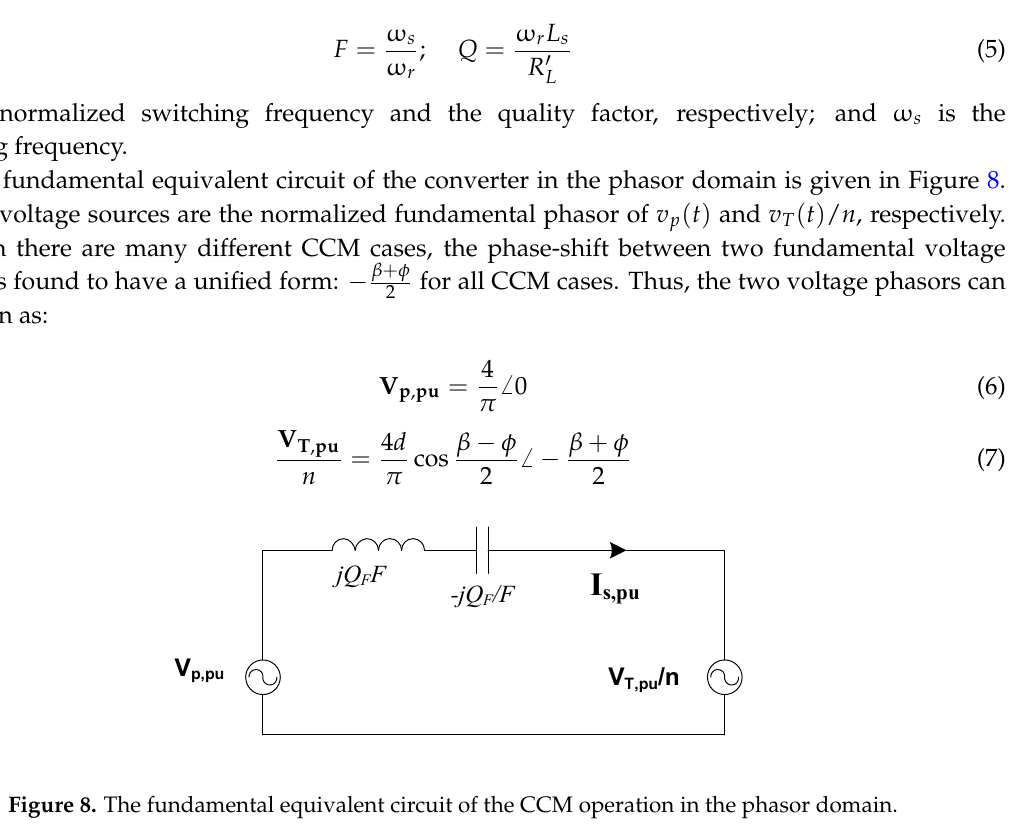
Figure 8. The fundamental equivalent circuit of the CCM operation in the phasor